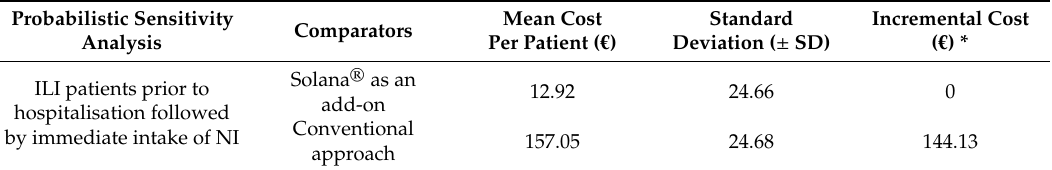
Table 4. Results of the probabilistic sensitivity analysis (Monte Carlo